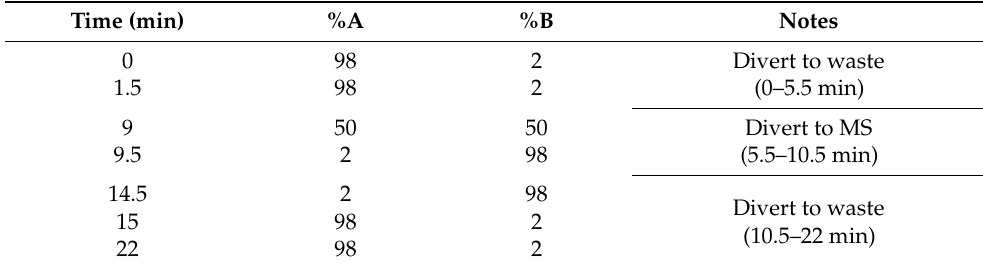
Table 2. The following solvents were used during the chromatography: Solvent A, 5 mM ammonium